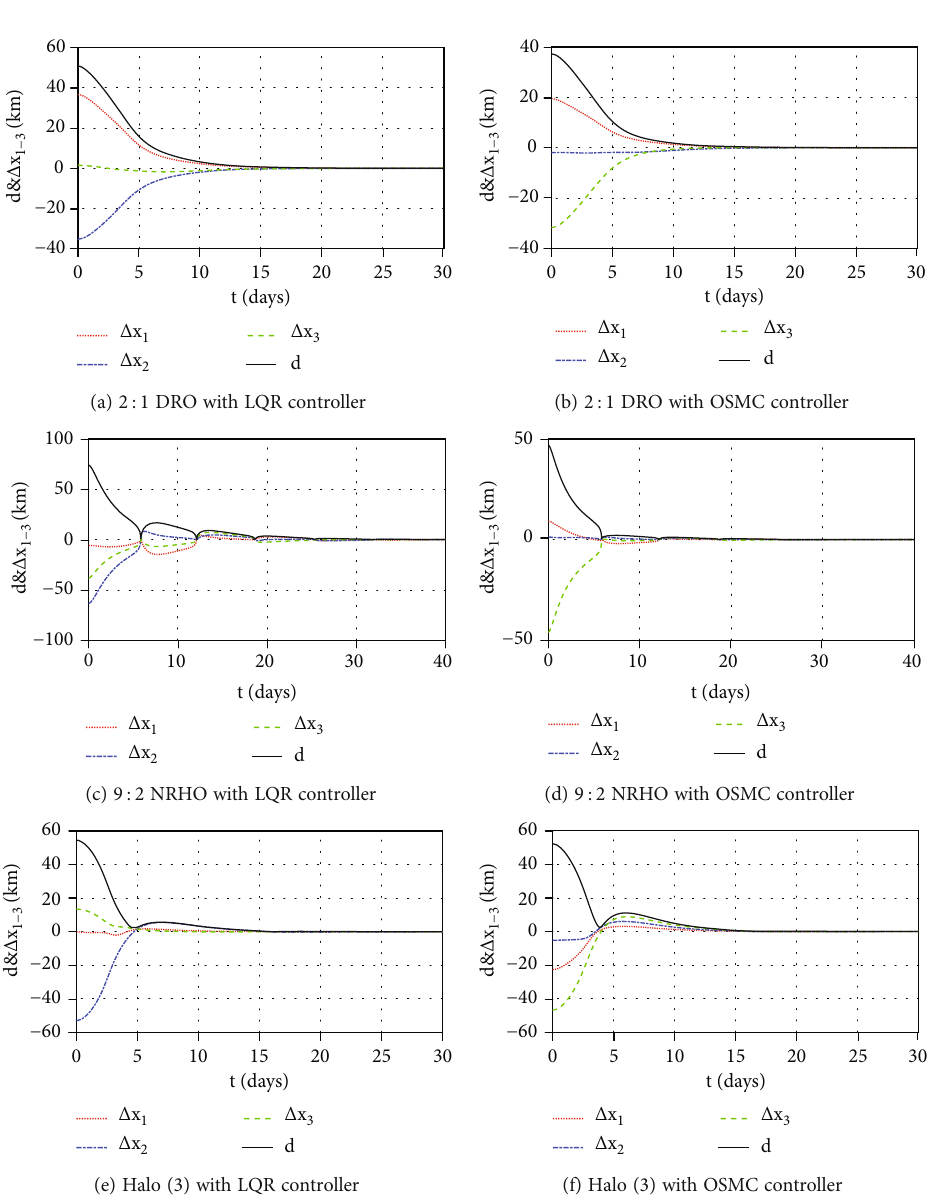
Figure 7: The station-keeping for the nominal orbits with the Jupiter gravity as the